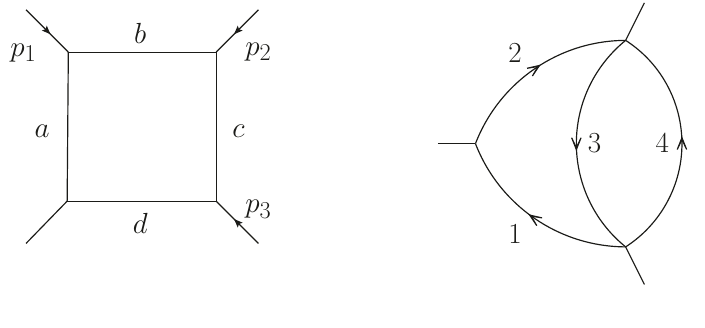
Figure 4 . Box and chestnut